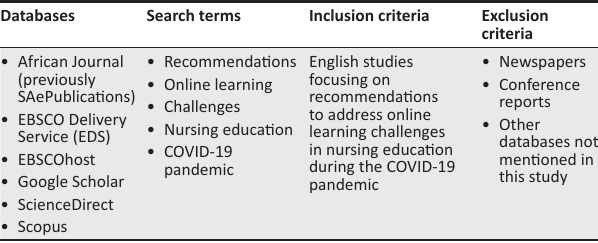
TABLE 1: Literature search.